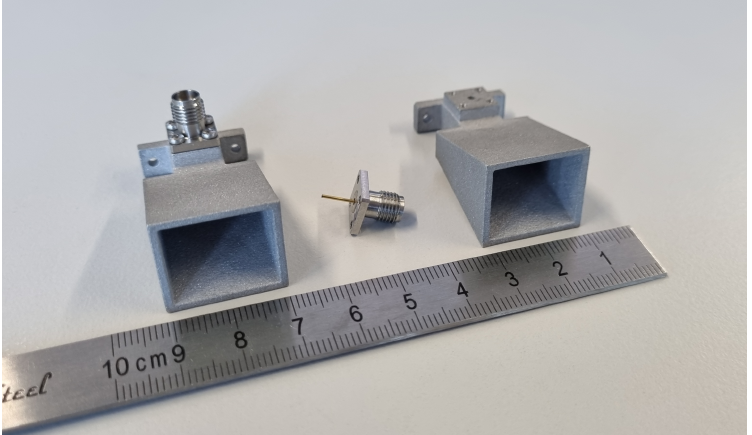
Figure 9. Two of the antenna elements produced by 3D printing of aluminum. One is shown with the mounted SMK connector and one without. The connector itself is also shown with the exposed pin. It can be seen that the surface roughness of the material is quite high.